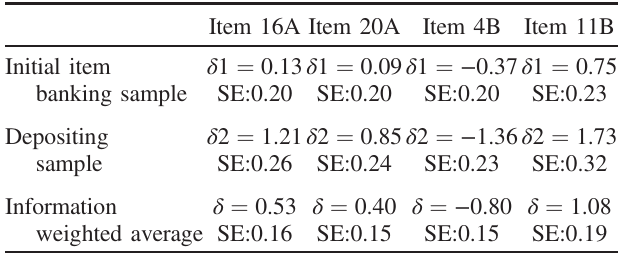
TABLE IV. Item difficulties and corresponding standard errors of four common items that functioned differently are given, together with the information weighted averages of these